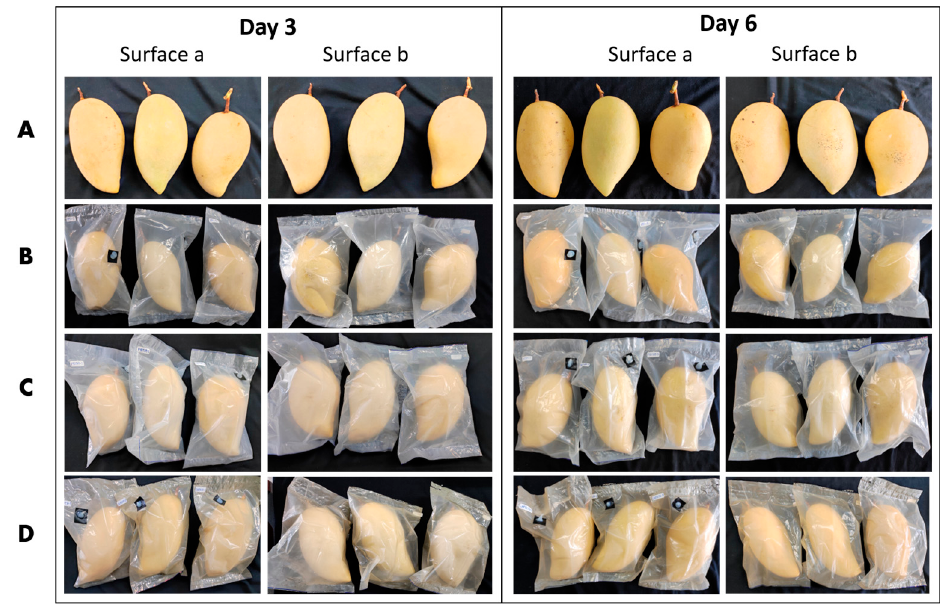
Figure 8. Mango fruit samples on days 3 and 6, stored at 12 °C and 90 ± 5% RH. ( A ) Control, ( B ) neat PBS, ( C ) PBS + 10T, and ( D ) PBS + 1SLNPs + 10T.